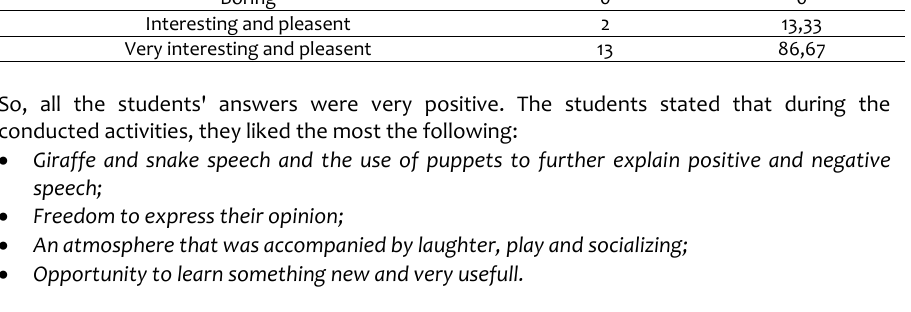
Table 7. Impressions of students about participation in the program after the research During the activity it was: